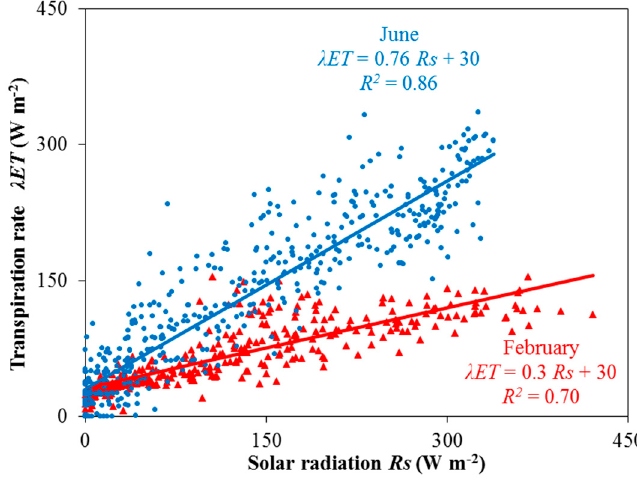
Figure 2. Correlation between solar radiation and crop transpiration rate as observed for a rose crop cultivation under winter and summer seasons, as presented by the authors of [25].